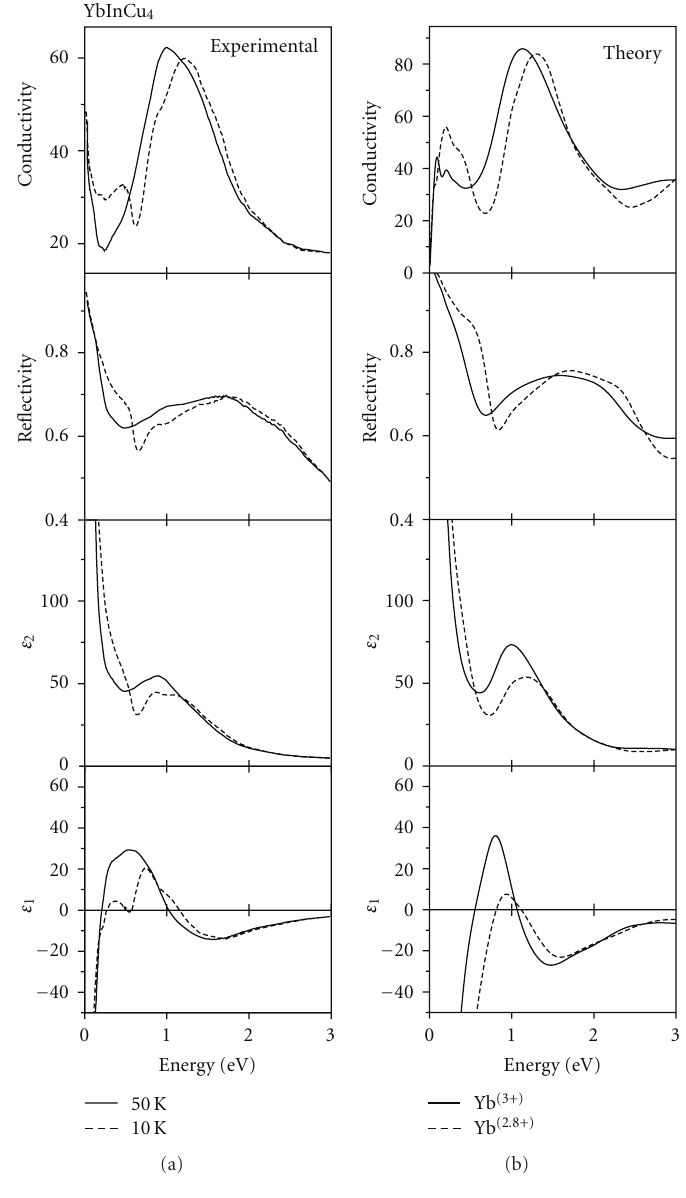
Figure 99: Comparison between the experimental optical spectra of YbInCu 4 measured below (10K) and above (50K) phase transition and calculated spectra for di ff erent occupation numbers of the hole 4 f state in the LSDA+ U approximation [475].